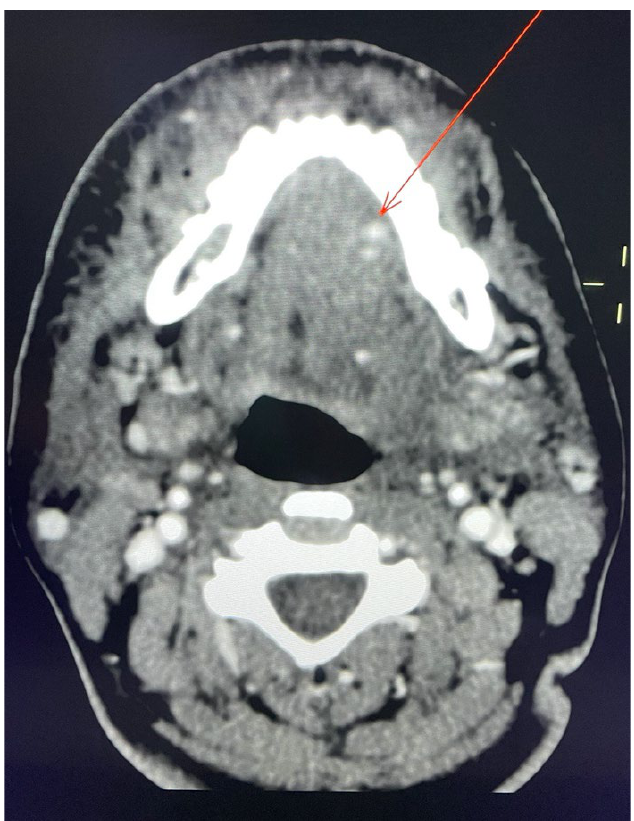
Figure 4. Contrast-enhanced computed tomography angiography (CTA), demonstrating a left lingual artery extravasation (arrow).